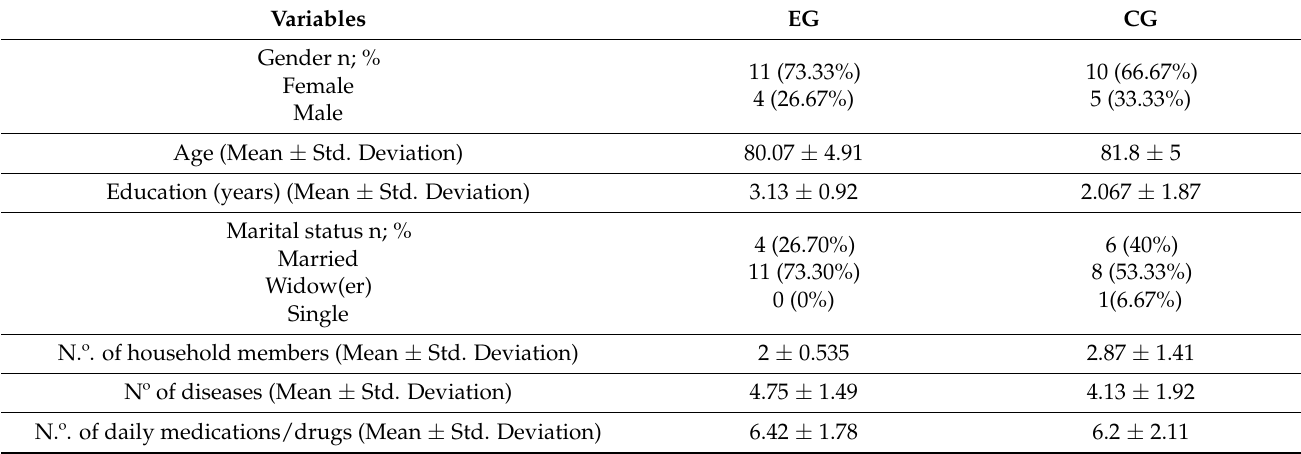
Table 2. Sociodemographic and clinical characterization of the experimental and control groups.